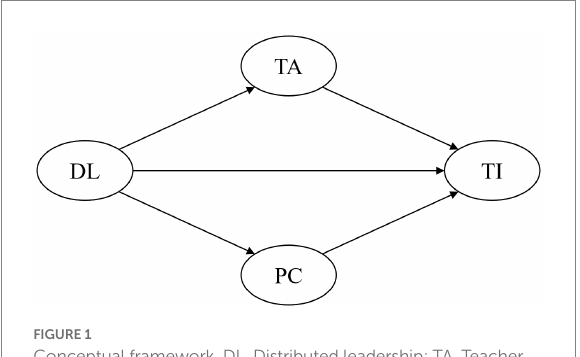
FIGURE 1 Conceptual framework. DL, Distributed leadership; TA, Teacher autonomy; PC, Professional collaboration; and TI, Teacher